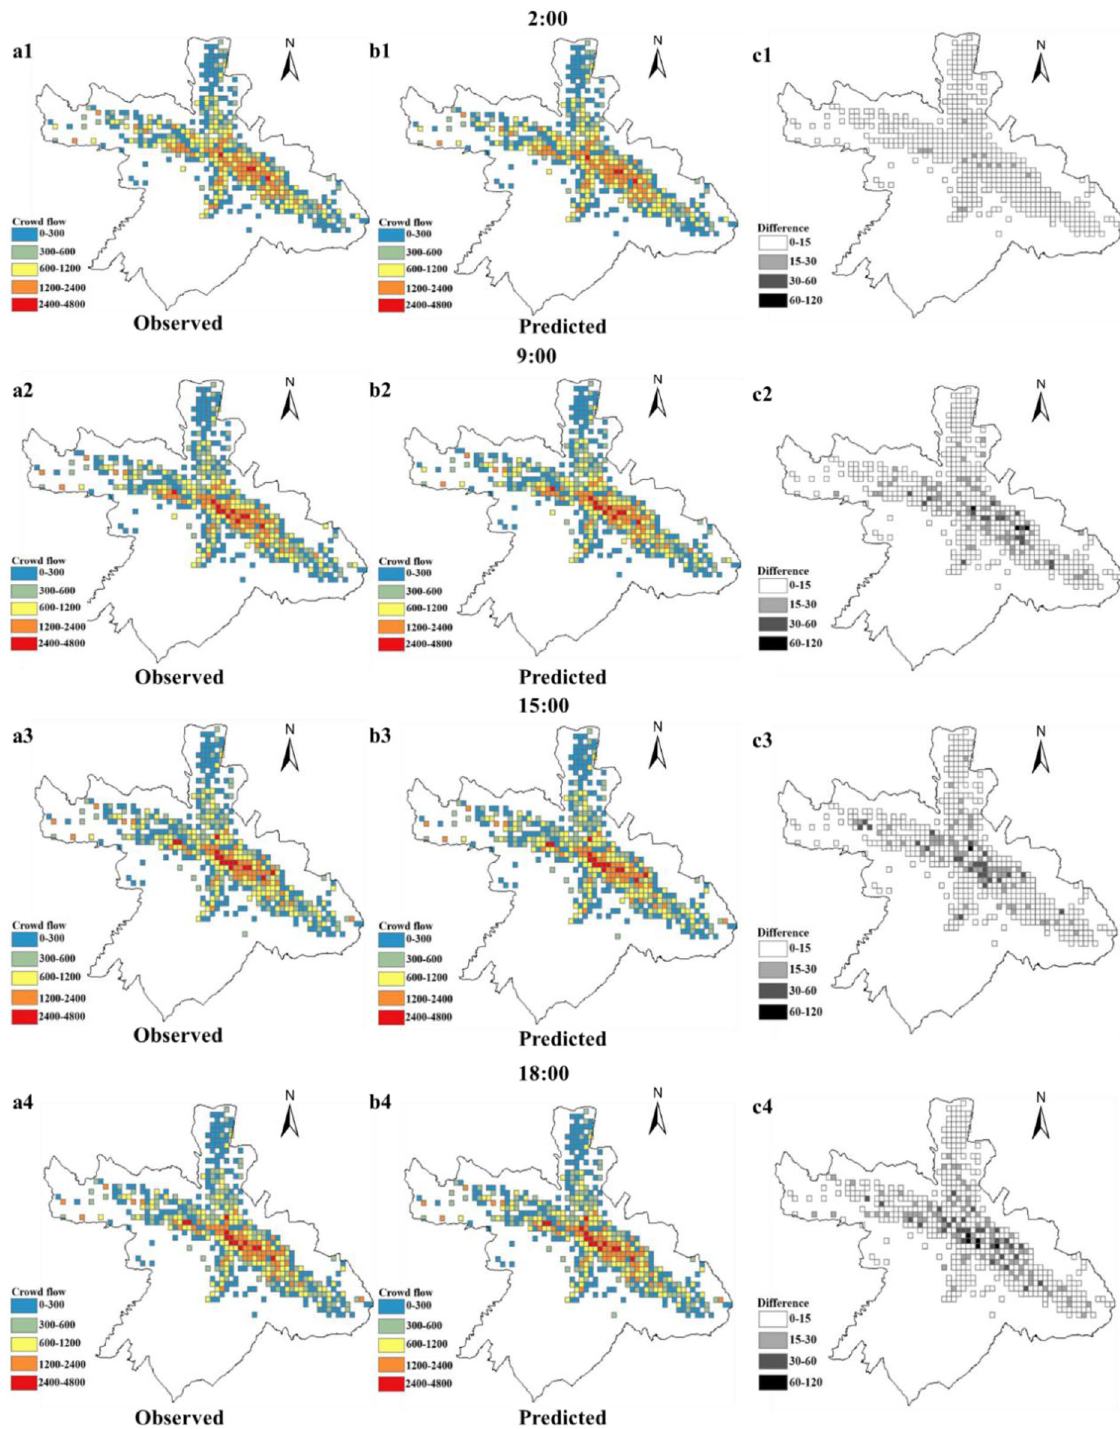
Figure 1. Crowd flow prediction